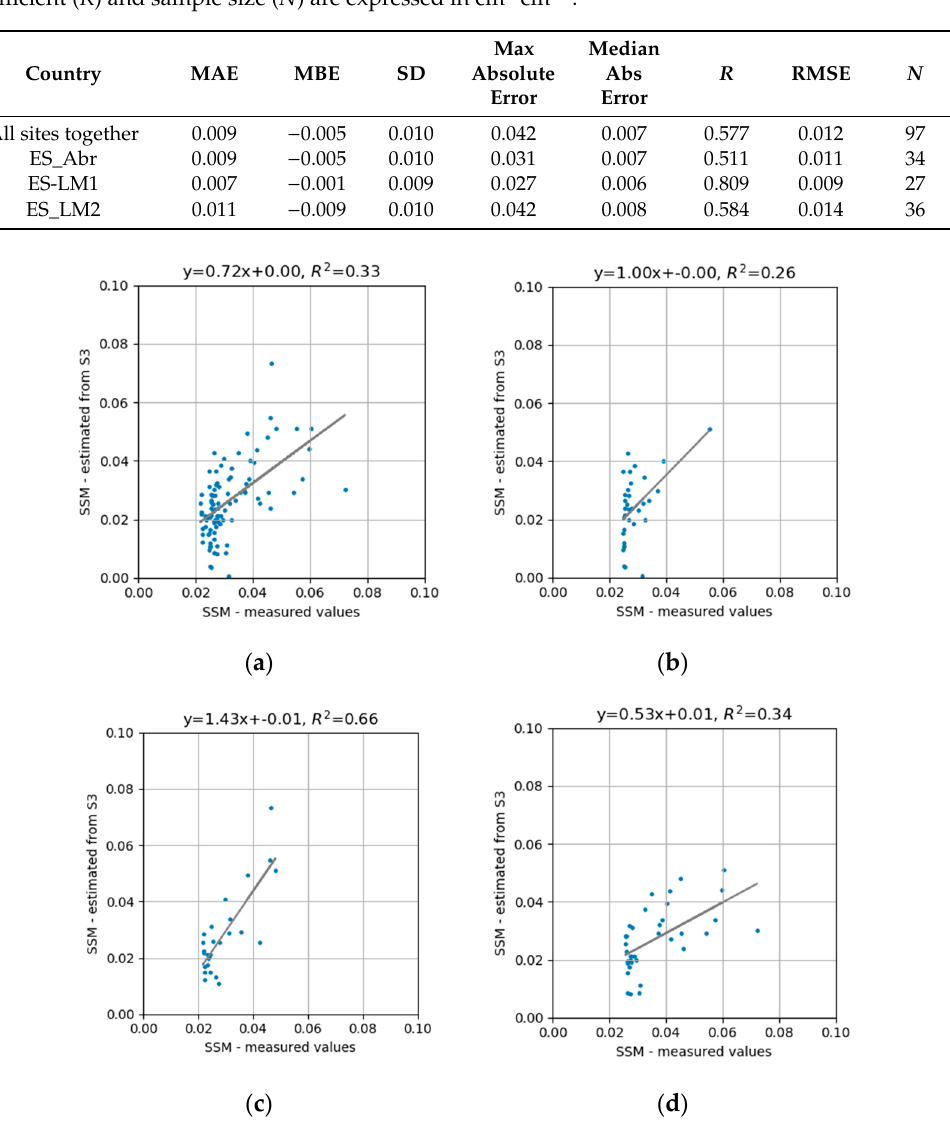
Figure 8. SSM comparisons: ( a ) for all sites in Spain, ( b ) for the ES-Abr site only, ( c ) for the ES_ELM1 site only and ( d ) for the ES-LM2 experimental site only. SSM units are cm 3 cm − 3 . Table 6. Summary of SSM comparisons per Fractional Vegetation Cover (Fr) for all the experimental sites and all parameters for the year 2018. All statistical parameters apart from correlation coefficient ( R ) and sample size ( N ) are expressed in cm 3 cm -3 .